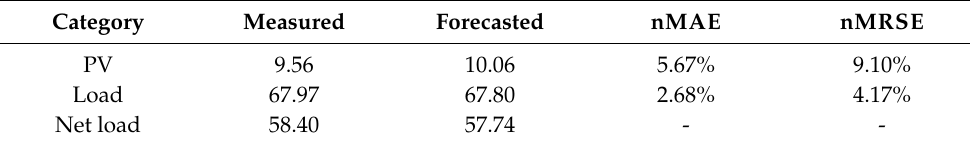
Table 4. Energy [MWh] predicted by Net Load Forecast and resulting errors on test